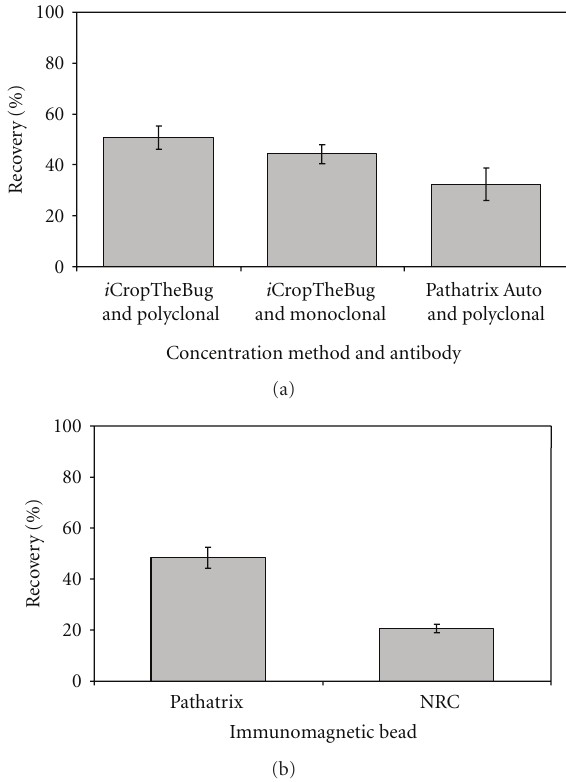
Figure 1: Comparison of di ff erent recovery methods, antibodies and immunomagnetic beads for the recovery of Y. pestis . (a) Patha- trix beads functionalized with polyclonal and monoclonal antibod- ies were compared for Y. pestis recovery using the i CropTheBug. The i CropTheBug and Pathatrix Auto systems were compared for recovery using Pathatrix beads functionalized with polyclonal antibody. (b) Pathatrix beads and NRC beads functionalized with polyclonal antibodies were compared using the i